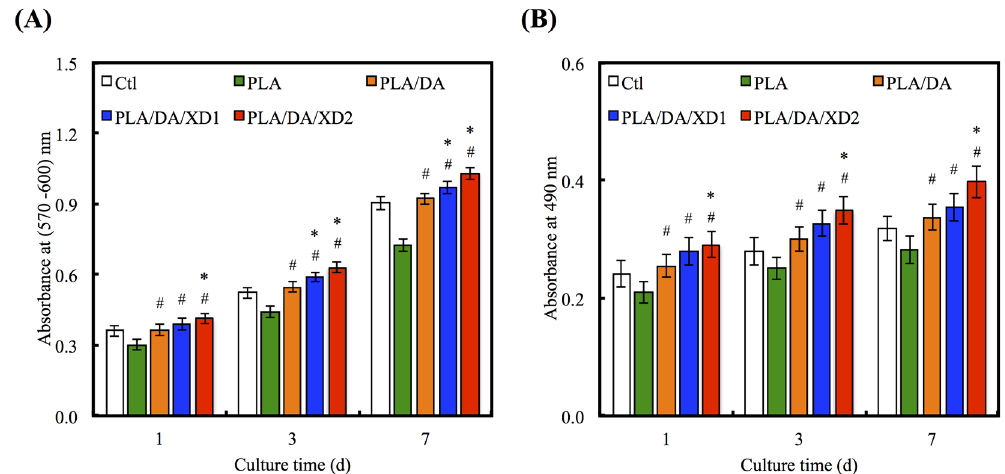
Figure 8. ( A ) PrestoBlue ® assay and ( B ) LDH assay of hBMSCs cultured on various specimens for different time points. The values shown are means ± standard errors for all the assays. “#” indicates a significant difference ( p < 0.05) compared to PLA; “*”